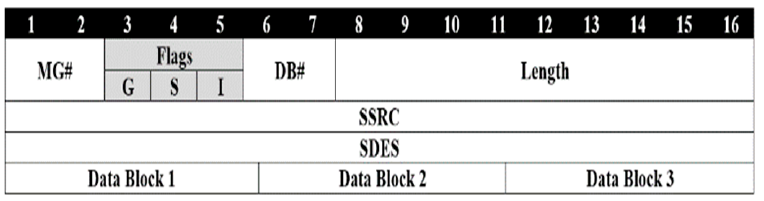
Figure 3. Simple view of a general-purpose control message from UM to HM. MG# [2 bits]: Message group number—Flags [3 bits]: G (Guidance), S (Stop), and I (Inform)—DB# [2 bits]: Number of data